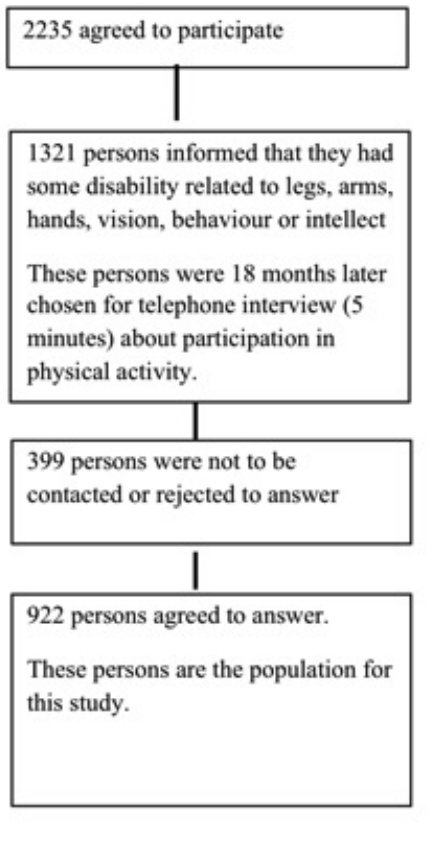
Figure 2 Sample selection